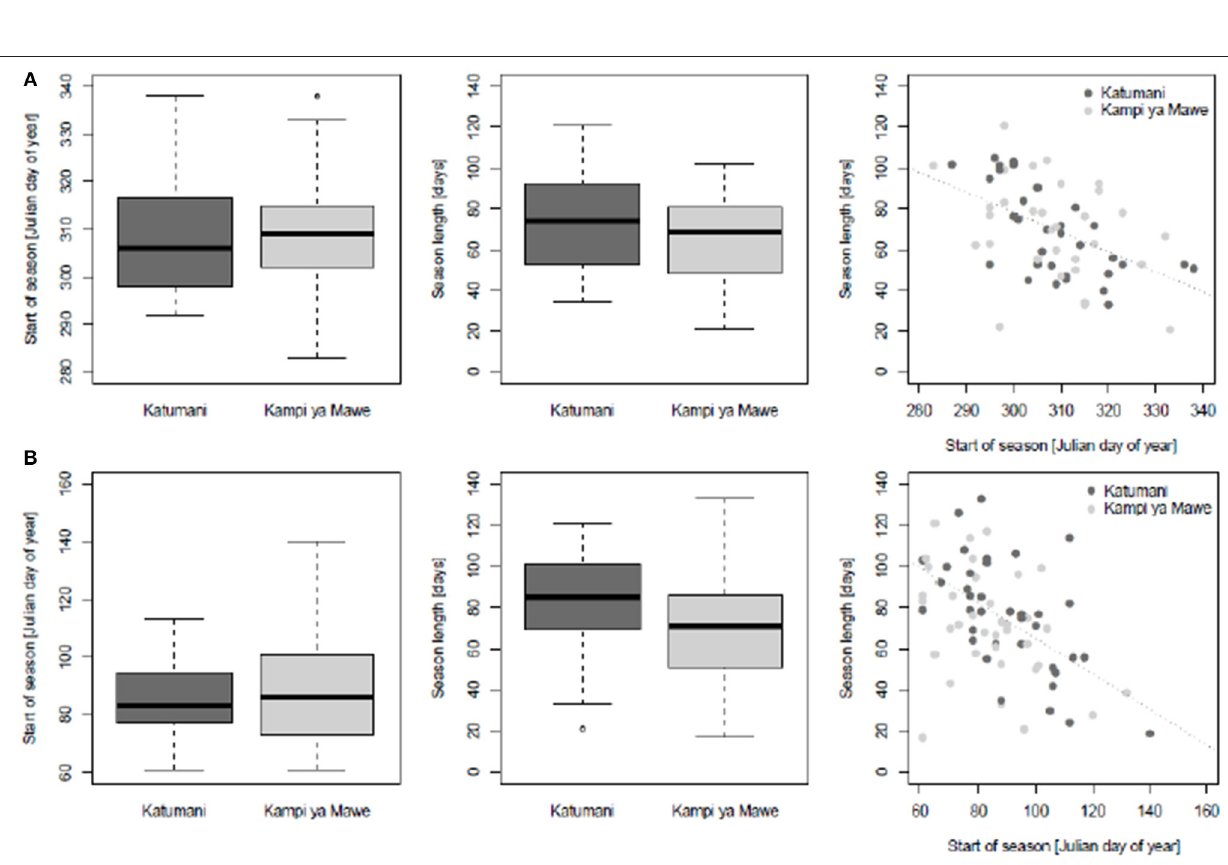
Frontiers in Plant Science | www.frontiersin.org